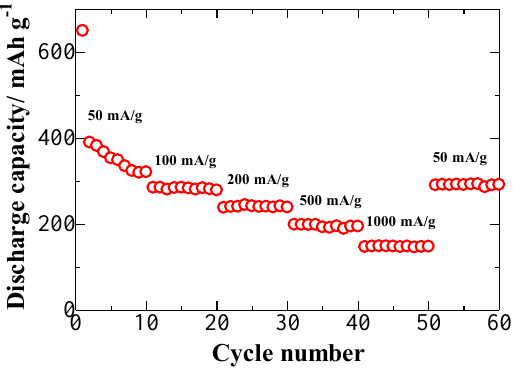
Figure 11. Rate performances of the C@Fe 2 O 3 composites at various current densities.